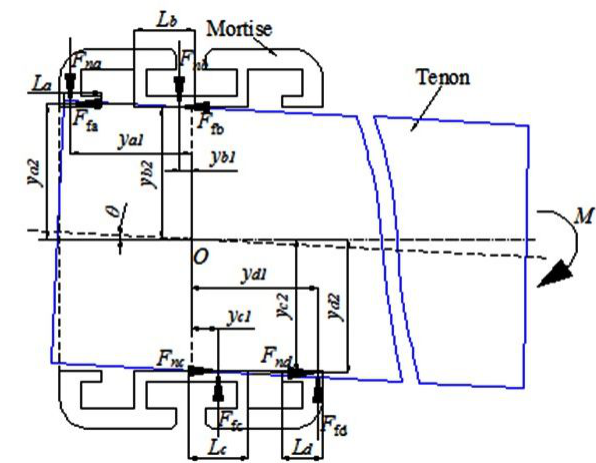
Figure 5: Deformation state diagram of MT-T joints under displace- Figure 6: Mechanical analysis of MT-T joints under horizontal re- ment load verse Where θ is the angular displacement between the ends of the joints, δ , δ , δ and δ are the squeezing deformation a c b d forarea a , b , c and d ,respectively, d and d arethegeomet- 2 s ric parameters of joints, respectively. The squeezing length satisfies the equations.